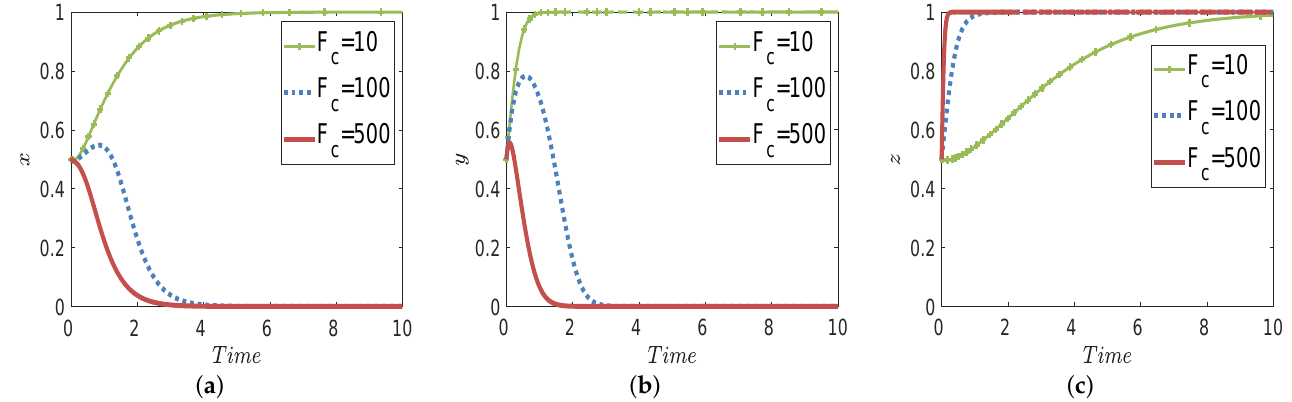
Figure 11. The impact of F c on evolution: ( a ) crowd workers; ( b ) crowdsourcing platforms; ( c ) task